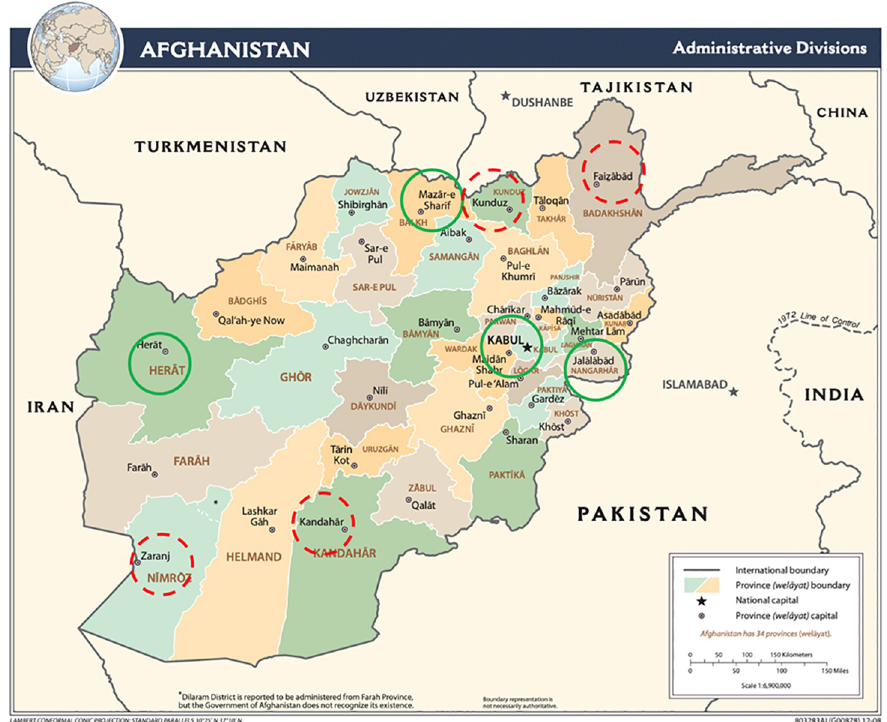
Fig 1. Location of study sites, Afghanistan, 2019 (green circles: A prior population size estimation of people who inject drugs was also conducted in these sites). Republished from [30] under a CC BY license, with permission from Central Intelligence Agency (CIA), original copyright